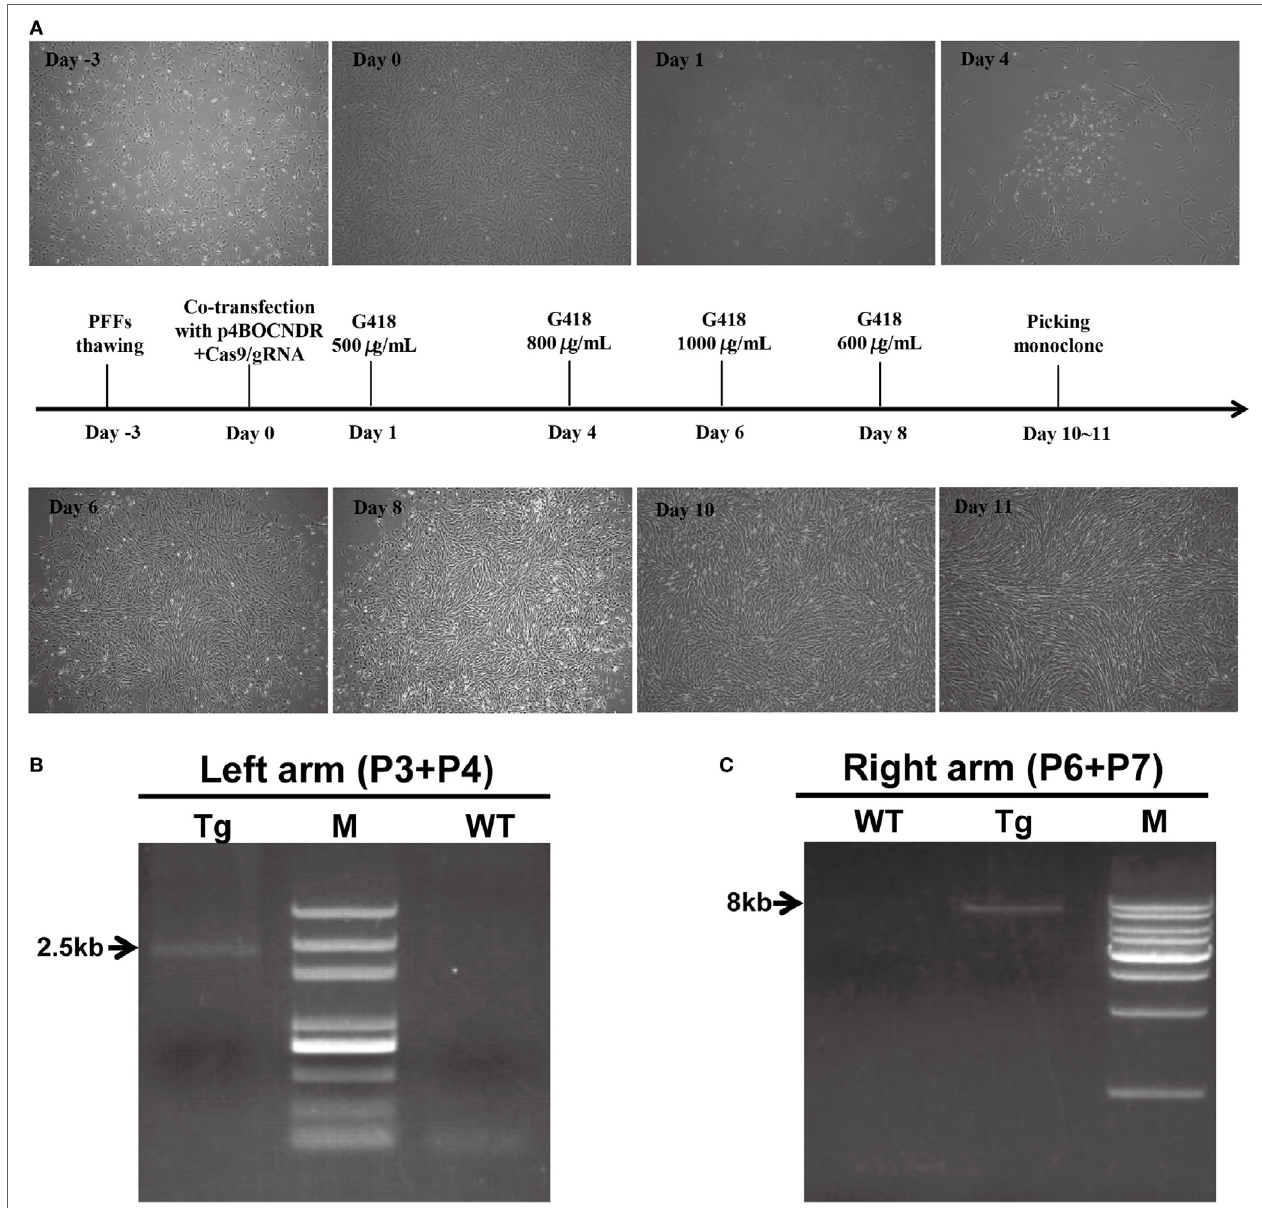
FigUre 2 | Clustered regularly interspaced short palindromic repeats/CRISPR-associated gene 9-mediated site-specific 4-1BB insertion in pig porcine fetal fibroblasts (PFFs). (a) Timeline of the PFF screening process. (B,c) Results of the PCR analysis of transgenic clones. The DNA markers (M) indicated in (B,c) were D2000 plus and a 1-kb DNA ladder, respectively. Tg, transgenic clone; WT,